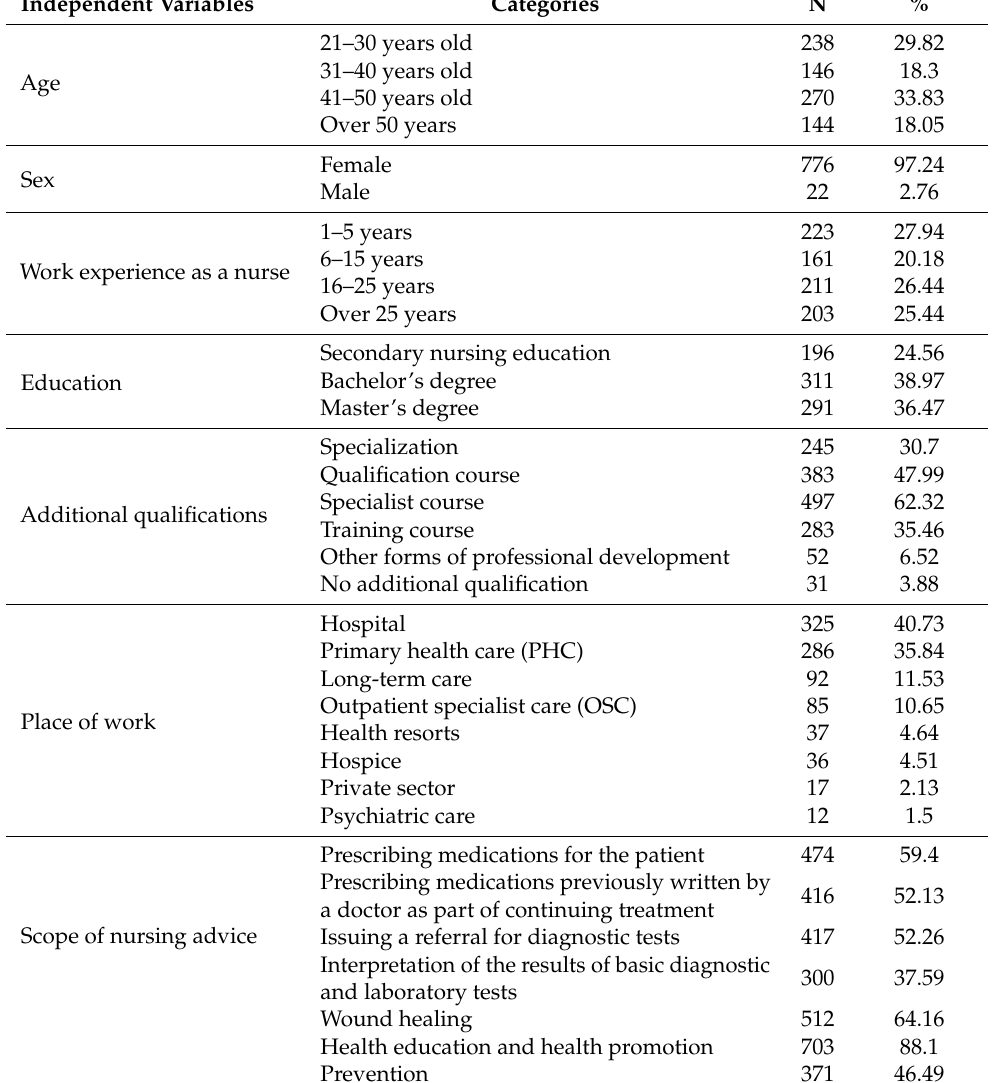
Table 1. Characteristics of the studied group (N =